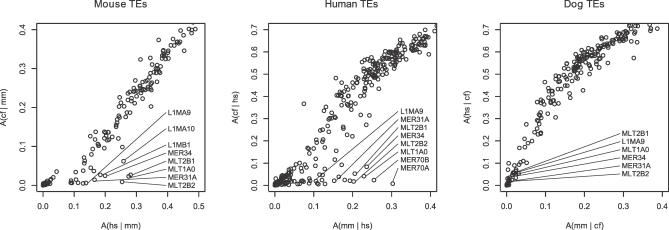
Evidence for the ((Human, Mouse), Dog) PhylogenyShown are the ancestralness A(y|x) for a range of TEs families in a species x (mouse, mm; human, hs; dog, cf), compared with the two remaining auxiliary species y. Data are shown for all TEs that were present in at least 500 copies covering 50 kb or more in species x. When x is the outgroup, the ancestralness is expected to be consistent across auxiliary ingroup species y, while for ingroup species, some TE families may be ancestral (A > 0) for the second ingroup, but lineage-specific (A ≈ 0) for the outgroup. All three scatter plots support dog as the outgroup species.